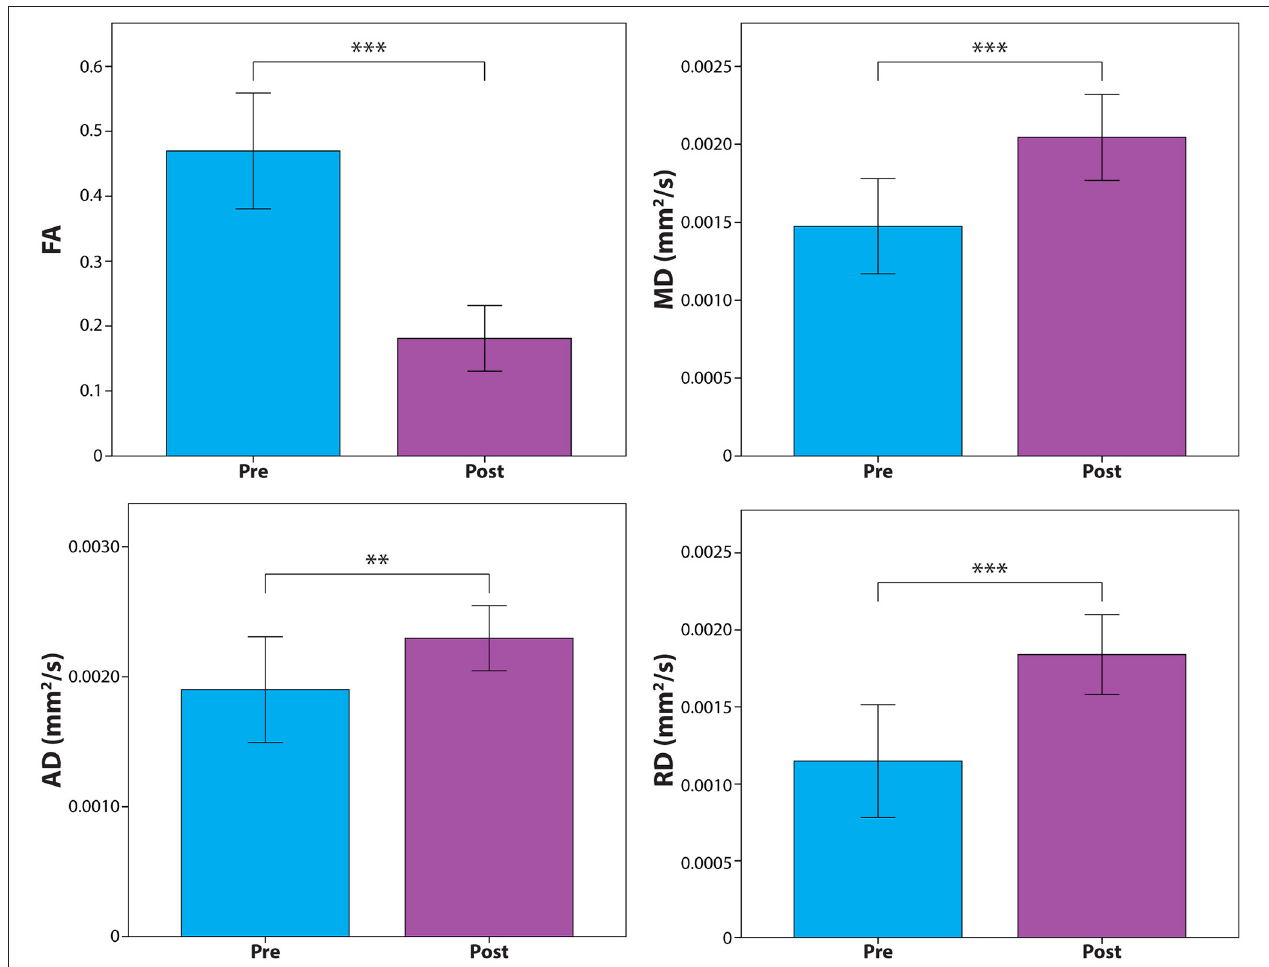
FIGURE 4 | Diffusion tensor metric assessment of the treated sciatic nerve segment before and after MRgFUS. Results show significant changes in fractional anisotropy (FA) and mean (MD), axial (AD), and radial diffusivity (RD). ** P < 0.01; *** P <